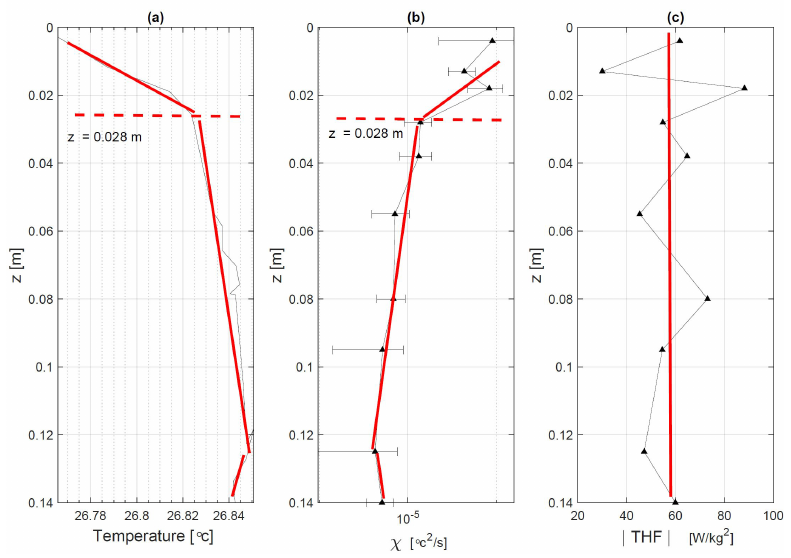
Figure 4. ( a ) The vertical profiles of temperature, ( b ) χ with associated error bars, and ( c ) turbulent heat flux | THF | . The data for all three graphs were collected at a downstream distance of x / M = 37. The mean flow velocity is < U > = 0.183 m/s, and the heater power was P 0 = 8.3 kW. The dashed red lines show the depth that the temperature and χ gradient changes. The graph fitting lines are presented with red lines. Note, the near-surface turbulent heat flux (THF) is approximately constant, as denoted by the red line segment ( c